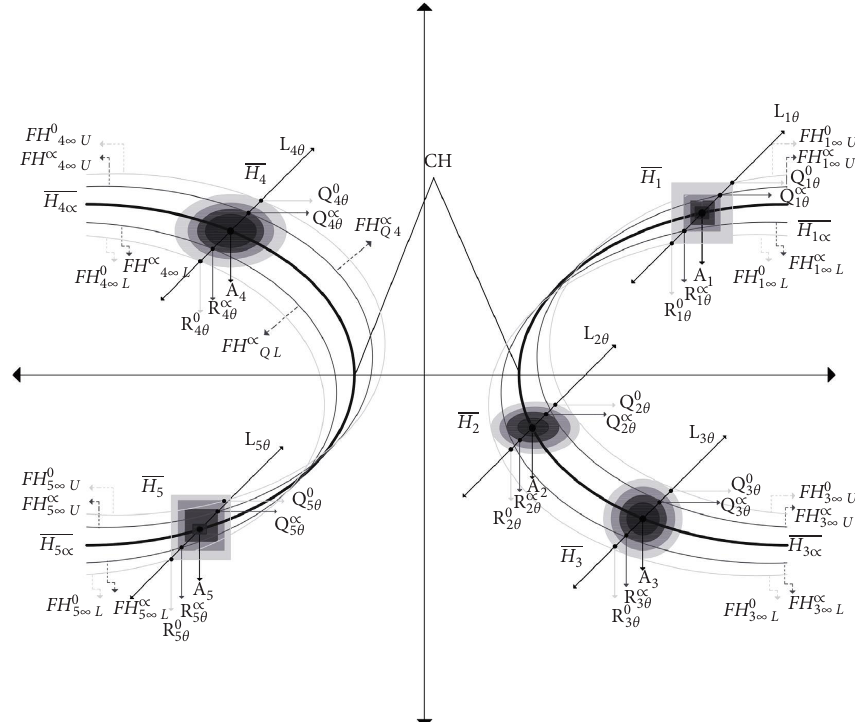
Figure 1: Construction of fuzzy hyperbola in the